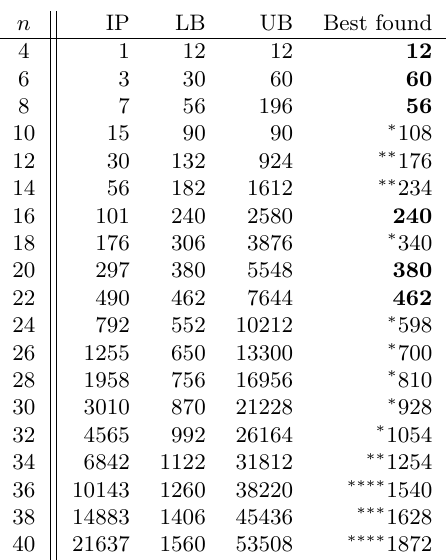
n 40 . COE-values ≤ ≤ 3 ( i.e. the number − 1) (corresponding to a balanced tournament) as −